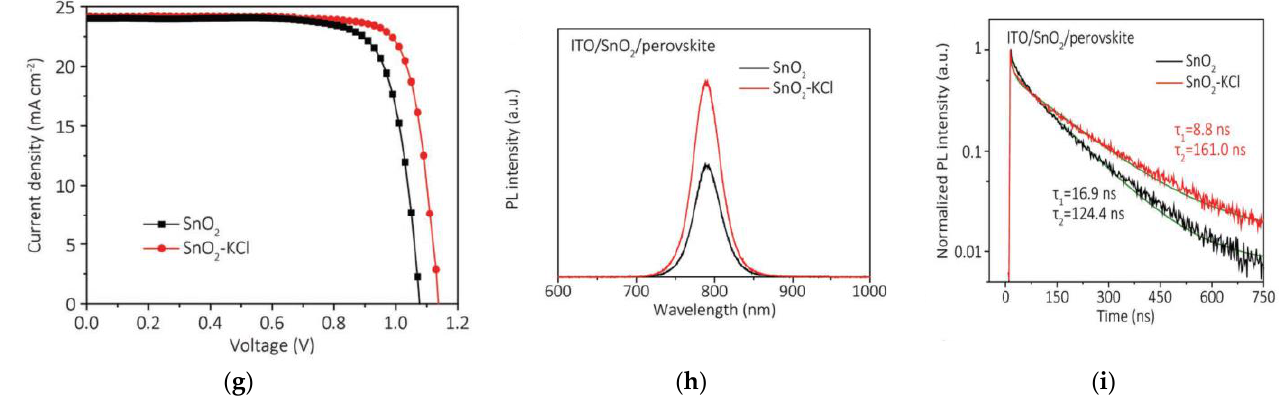
Figure 4. ( a ) Energy-band levels of each layer in the PSC. ( b ) Illuminated J - V curves under 1 SUN for reverse- and forward-voltage scanning of SnO 2 and CoCl 2 :SnO 2 -based PSC devices. ( c ) Stability measurements of devices with various ETLs in N 2 atmosphere under continuous irradiation. Reproduced from [46] with permission from ACS Publications, 2021. ( d ) Illustration of incorporation of heparin potassium (HP) into the SnO 2 nanocrystal dispersions, resulting in arrangements of ETL nanocrystals, and crystal growth of the perovskite films with and without heparin potassium. ( e ) Illuminated J - V curves under 1 SUN for reverse- and forward-voltage scans of PSCs with and without HP incorporation into SnO 2 . ( f ) Long-term MPPT-stability measurements of devices with different ETLs for 1000 h under continuous 1 SUN illumination. Reproduced from [47] with permission from Wiley, 2020. ( g ) Illuminated J - V curves under 1 SUN for various ETLs. ( h ) Steady state PL and ( i ) TRPL spectra for various ETLs. Reproduced from [48] with permission from Wiley, 2020.